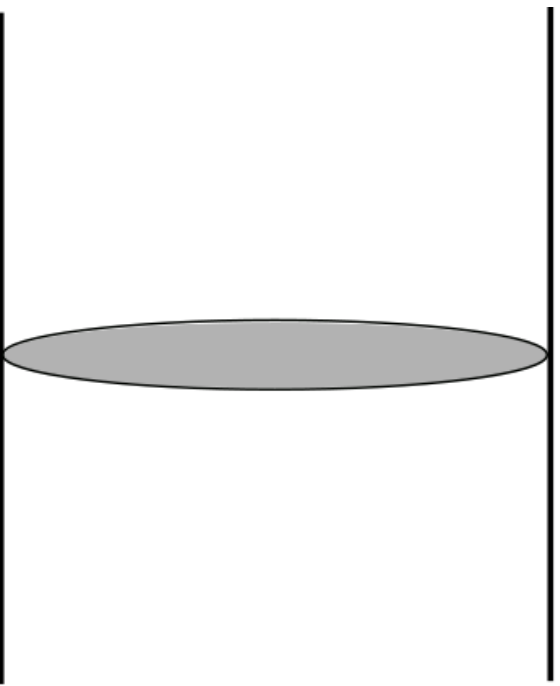
Figure 1. A gluon bundle(shaded oval) exchanged between two quarks (solid